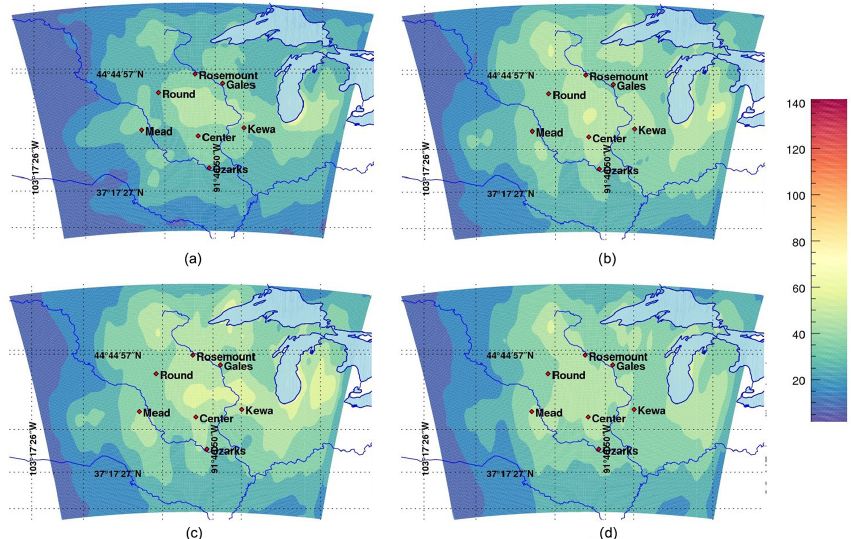
Figure 5. Monthly averages of the filtered variances of in situ CO 2 mole fractions (about 100ma.g.l.) (in ppm 2 ) using 25 members (a) , 10 members (b) , 8 members (c) and 5 members (d)